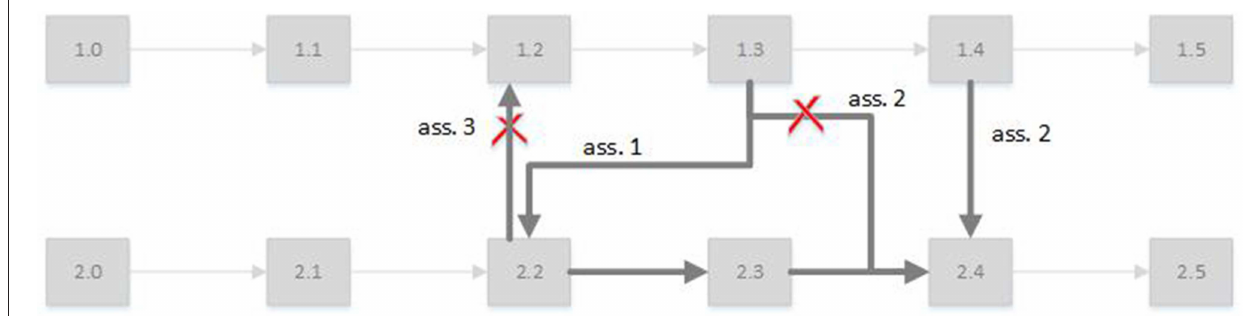
FIGURE 2 | General example of a generic Migration Path (source: own illustration).